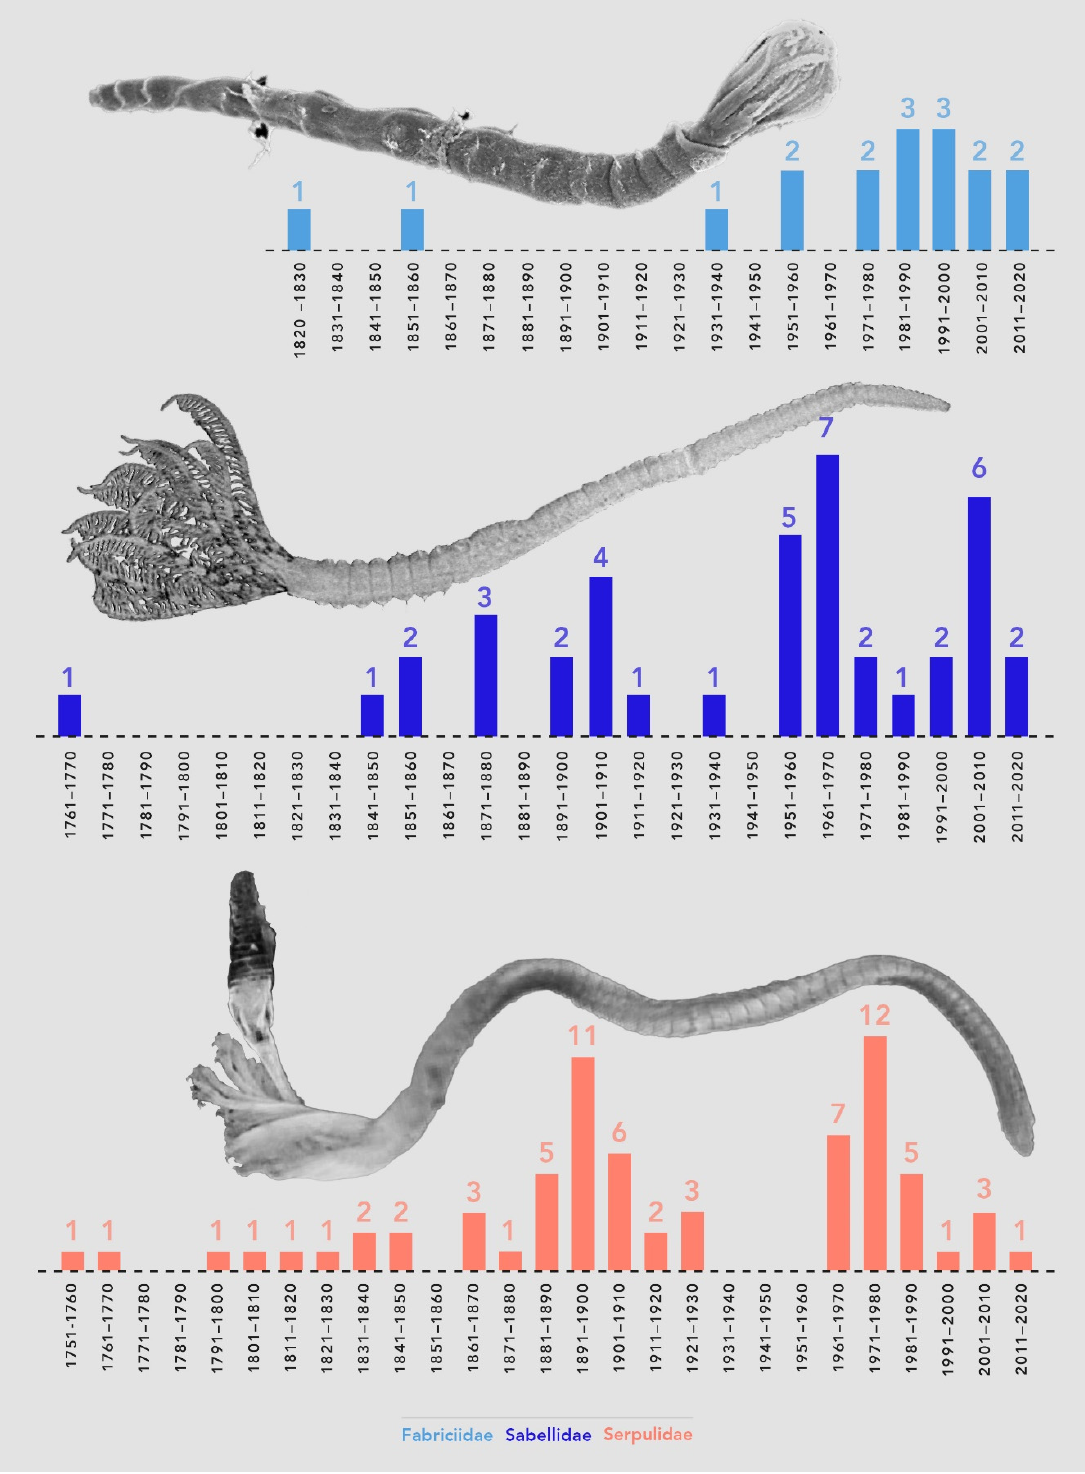
Figure 6. Number of genera erected each decade in Fabriciidae, Sabellidae, and Serpulidae.